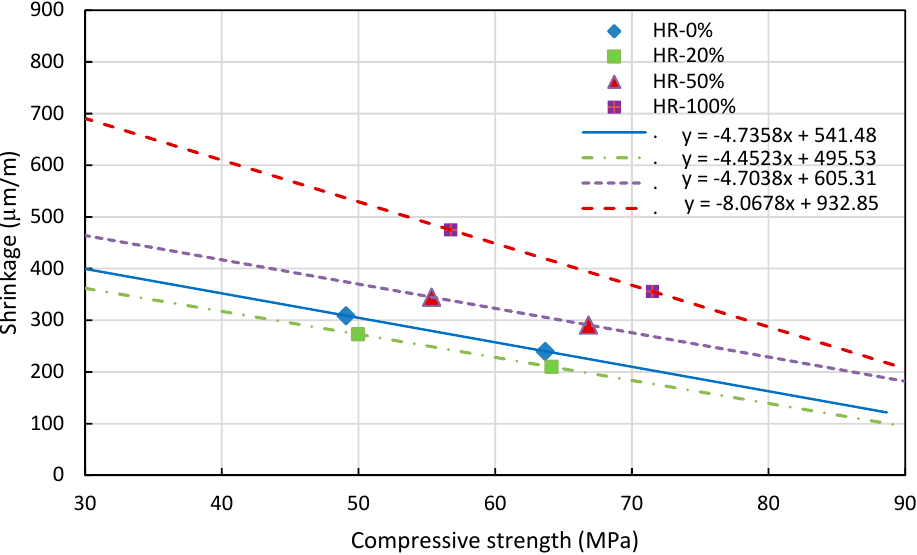
Figure 9. Correlation between shrinkage and compressive strength at 28 days’ ageing.